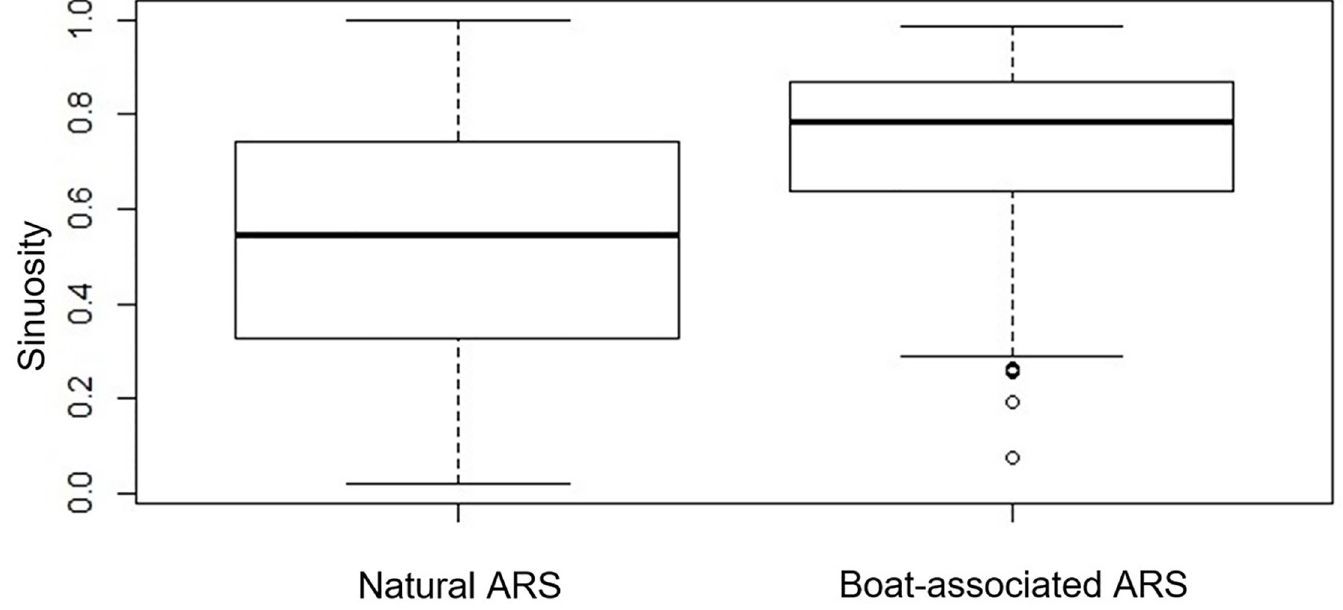
Fig 4. Sinuosity boxplot of small scales ARS: Natural ARS are significantly different than ARS associated with a boat.